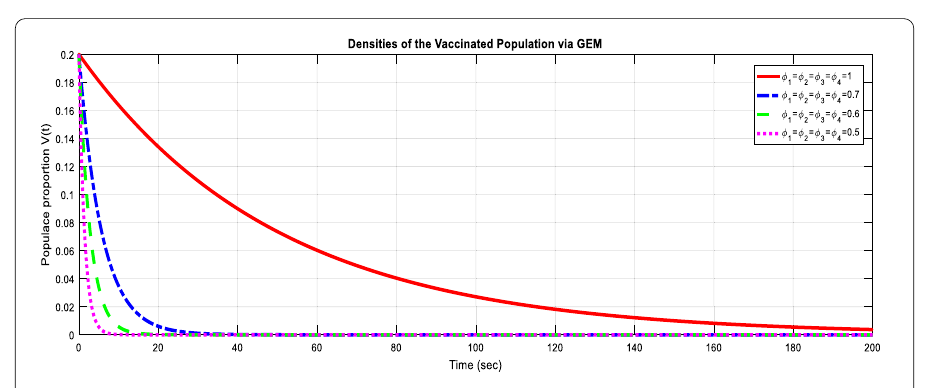
Figure 8 Dynamic of V by varying the value of φ